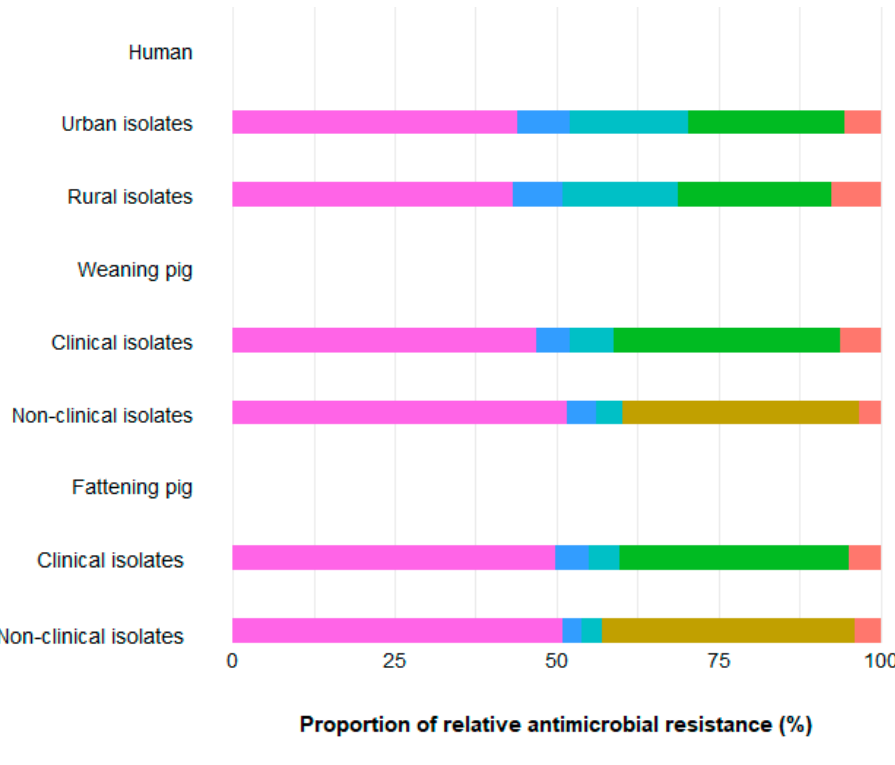
Figure 3. Proportion of relative resistance in all populations. In nonclinical isolates from pigs, resistance to trimethoprim was considered instead of resistance to the combination of trimethoprim and sulphonamides as data on resistance to the combination were not available. Positive associations between AMU and AMR were encountered in clinical isolates of fattening pigs for ampicillin and in human isolates for co-trimoxazole. This association was also found between the consumption of aminoglycosides and gentamicin in human